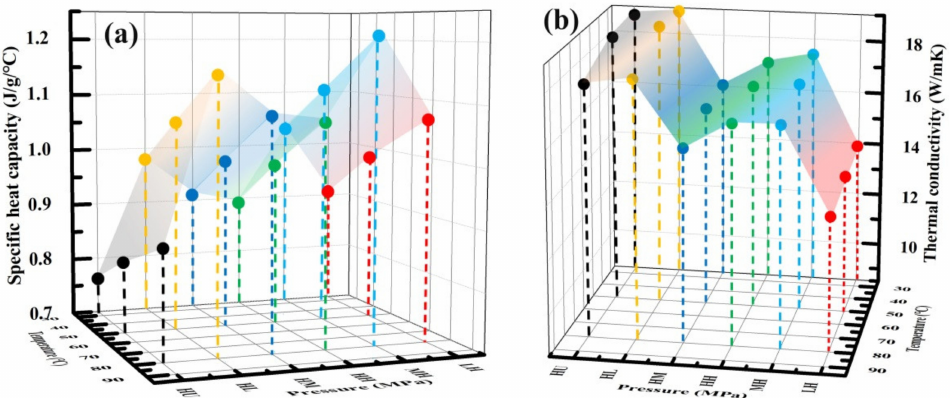
Figure 6. Thermal properties of composite BPs. ( a ) Specific heat capacity and ( b ) TP thermal conductivity of composite BPs under different